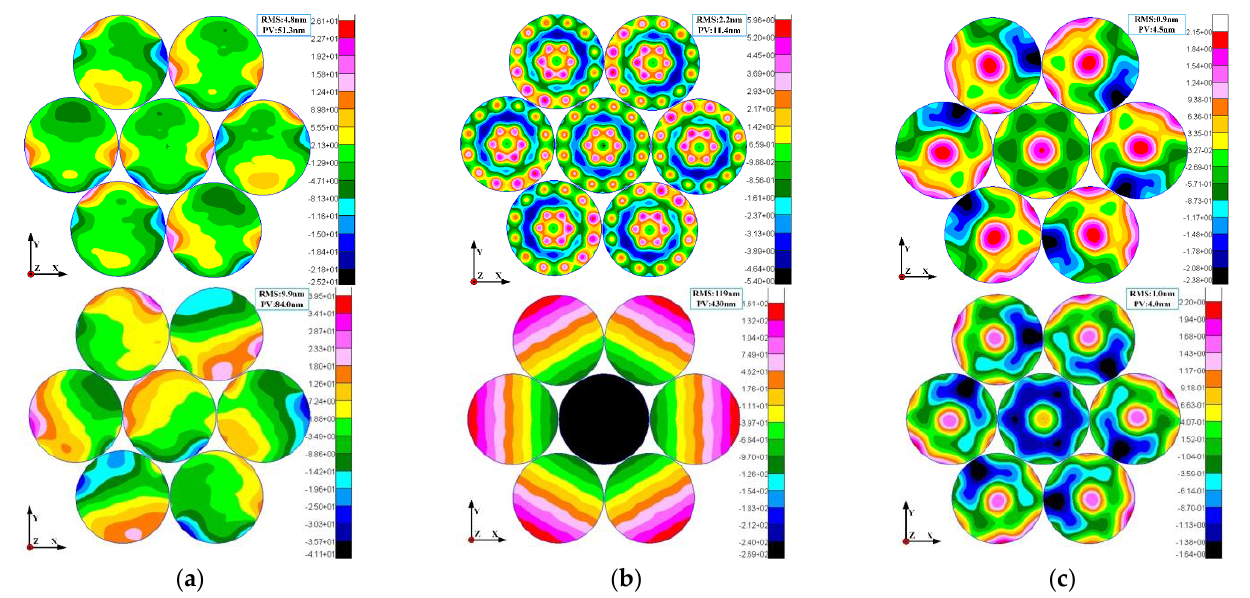
Figure 6. Residual deformation of the mirror surface after aberration correction for Scheme 1 ( top ) and Scheme 2 ( bottom ), ( a ) Deformation of mirror surface in Y condition, ( b ) Deformation of mirror surface in Z condition, and ( c ) Deformation of mirror surface in T condition.